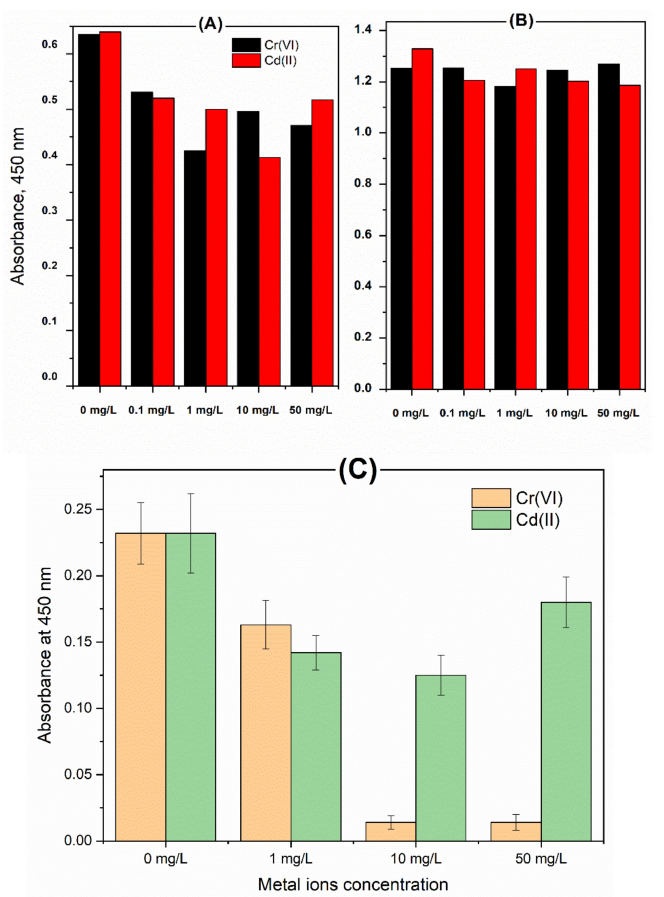
Figure 2. Testing the cell viability of treated Rhodotorula ALT72 ( A ) and Rhizobium -MAP7 ( B ) using WST-test and ( C ): testing the cell viability of Pantoea agglomerans using